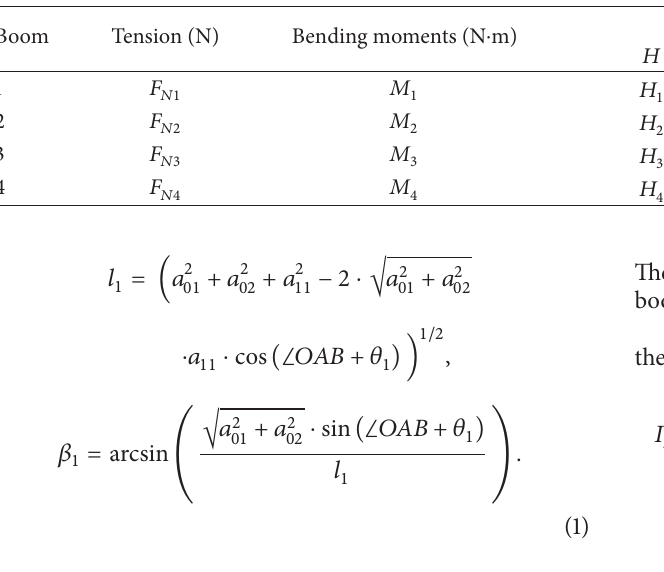
Table 3: Boom variables of the stress